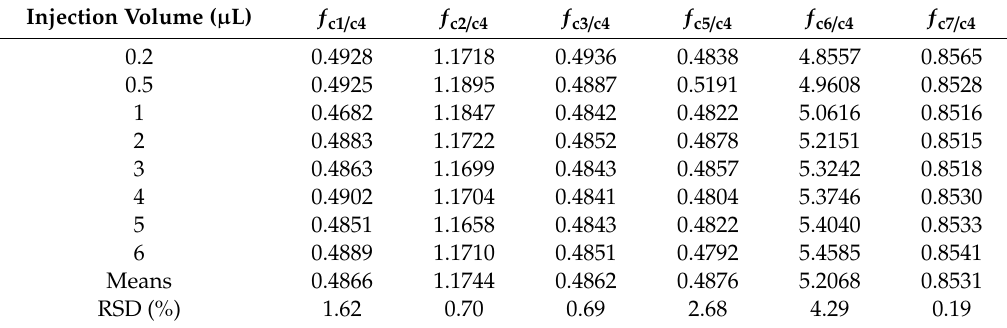
Table 7. RCFs in di ff erence injection volumes.